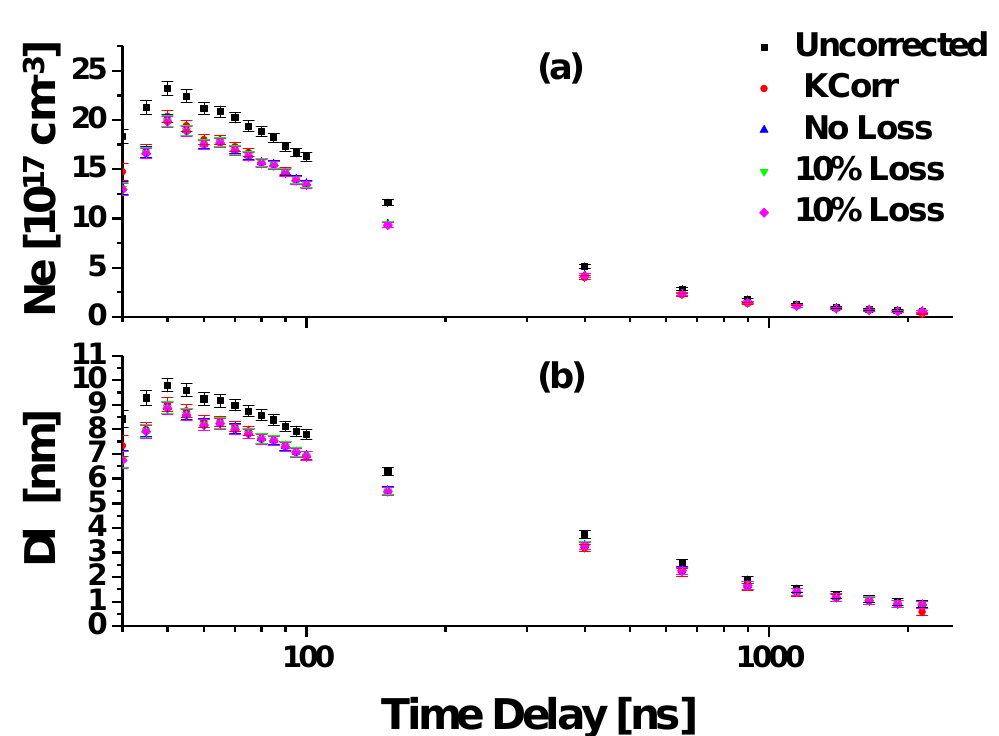
Figure 8. Decay of the plasma ( a ) electron density and ( b ) H α line width through